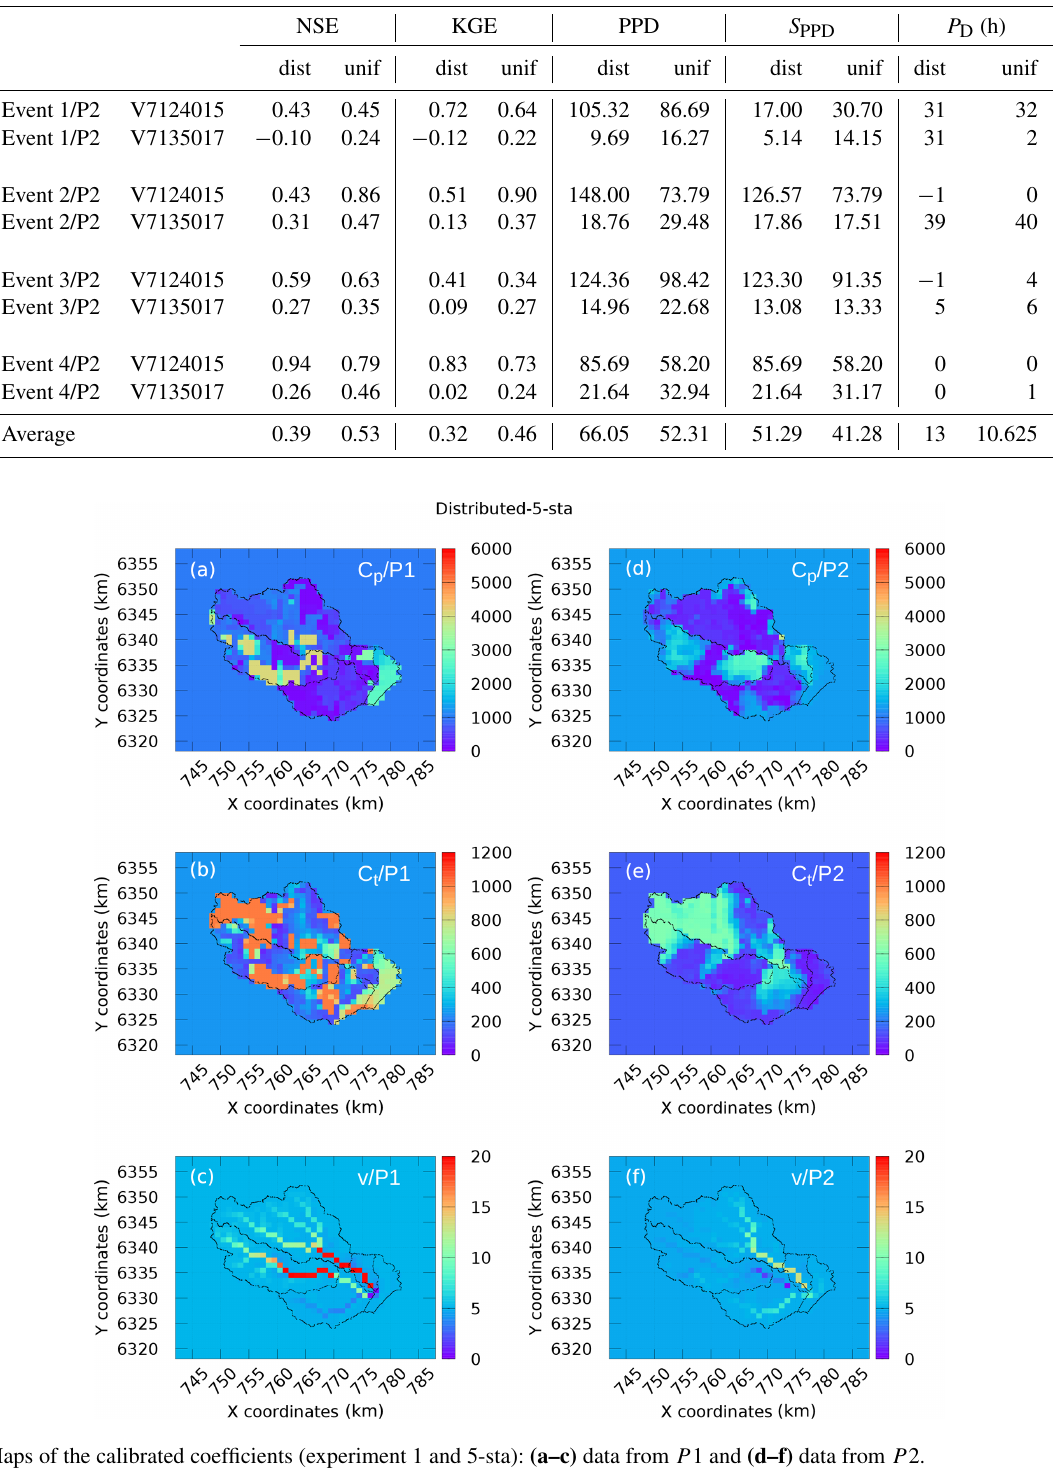
Table 4. MPP criteria (NSE, KGE, S PPD and P D ) computed for major flood events selected over the period P 2, using distributed (dist) and uniform (unif) calibration over P 1.